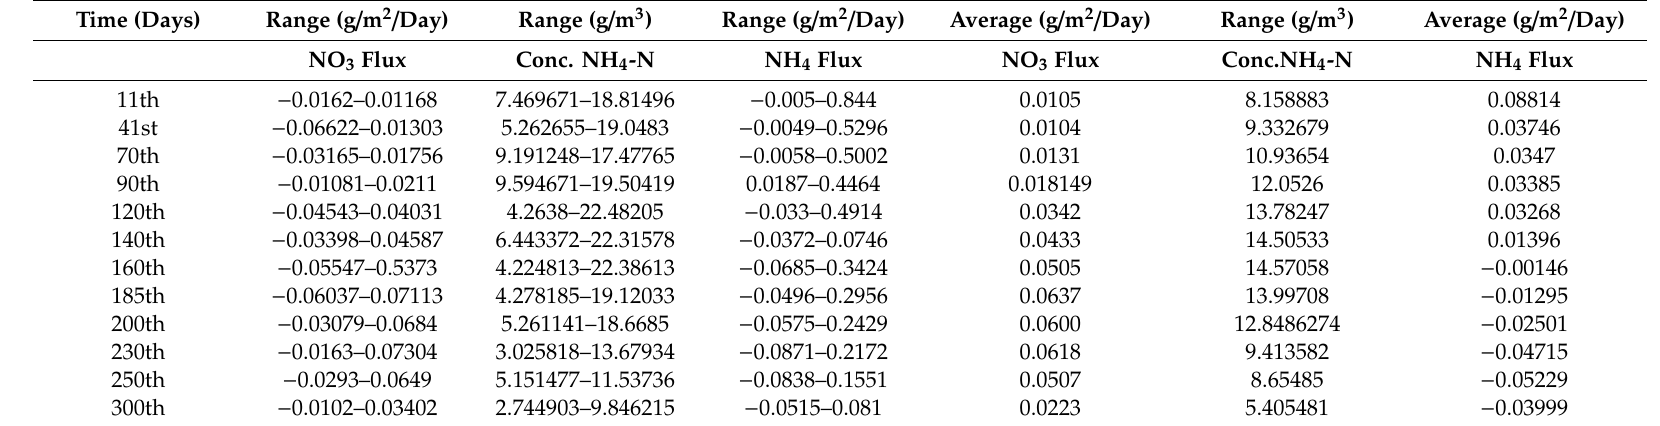
Table 2. Shows the seasonal, ranges, and average concentration of NH 4 –N, sediment fluxes of NO 3 , and NH 4 at Lake